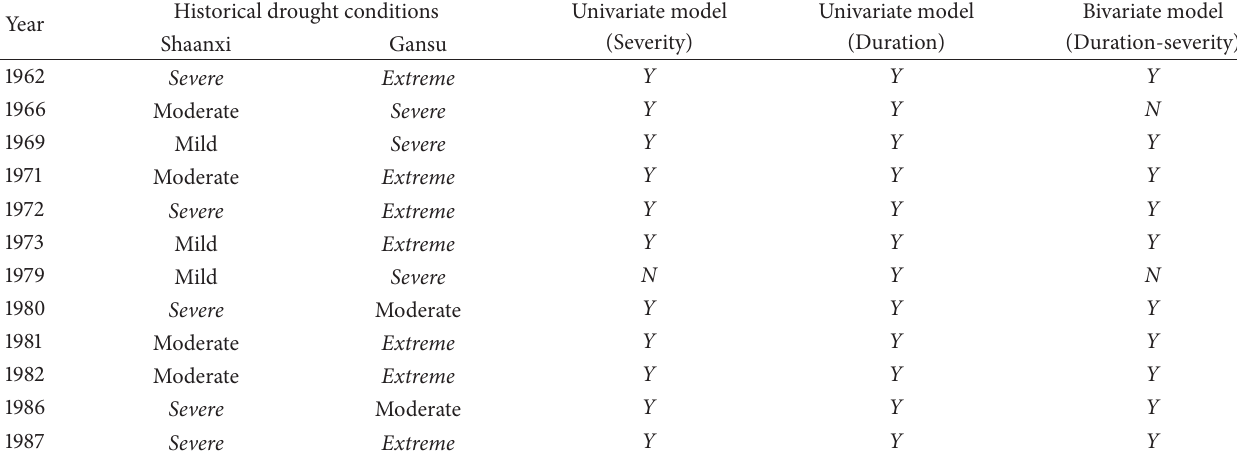
Table 3: Validation of univariate/bivariate model-based droughts against historical severe and extreme drought records in the baseline period (1961–1990).